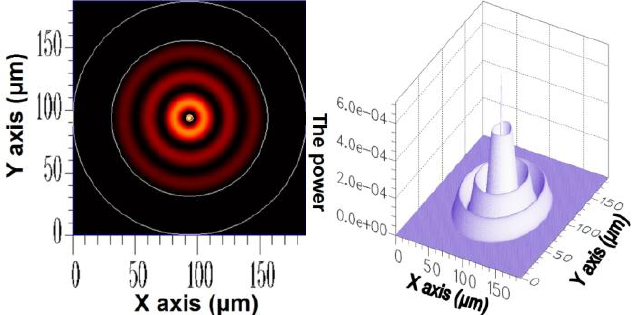
Figure 5. The 2D and 3D power diagram of the cladding mode ( ν = 5) with an effective refractive index